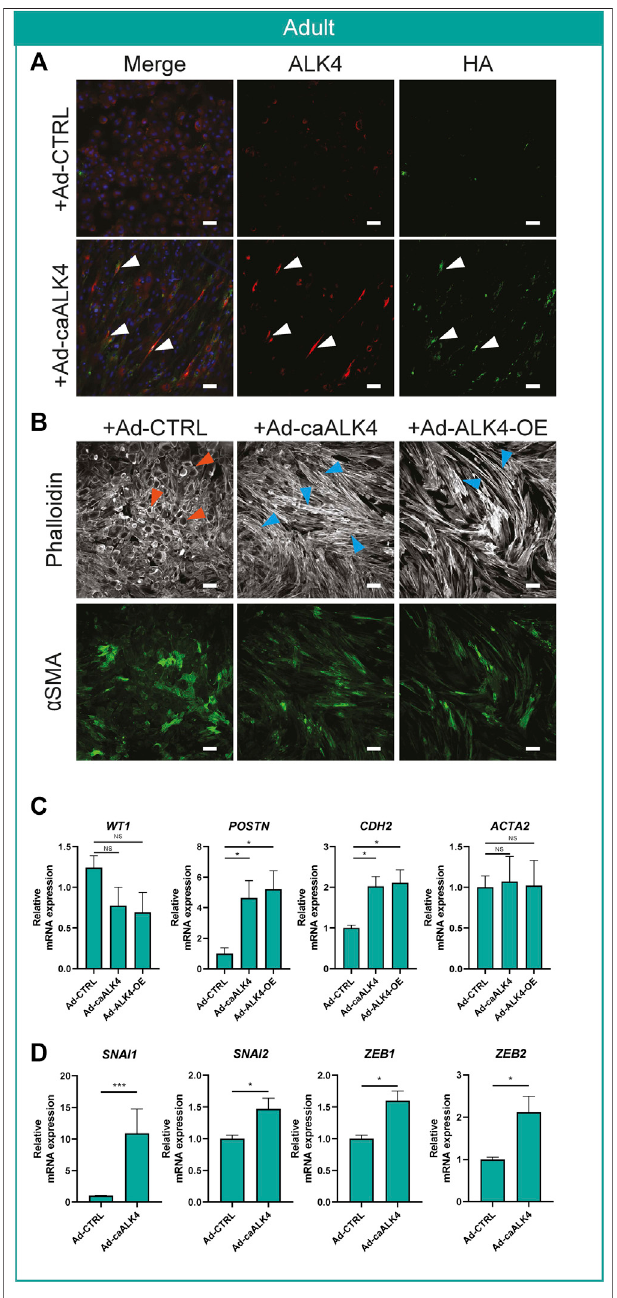
FIGURE 3 | Activin receptor ALK4 overexpression induces epiMT in adult EPDCs (A) Representative example of ALK4 and HA staining in Ad-CTRL and Ad-caALK4transducedadultEPDCs.Arrowsindicateco-localizationofALK4and HA in Ad-caALK4 treated cells. (B) Phalloidin and α SMA staining of adult EPDCstransducedwithAd-CTRL,Ad-caALK4orAd-ALK4-OE( n (cid:1) 3).Scalebar: 100 µm.Orangearrowsindicateexamplesofepithelialcobblestone-shapedcells, bluearrowsofmesenchymalspindle-shapedcells. (C)